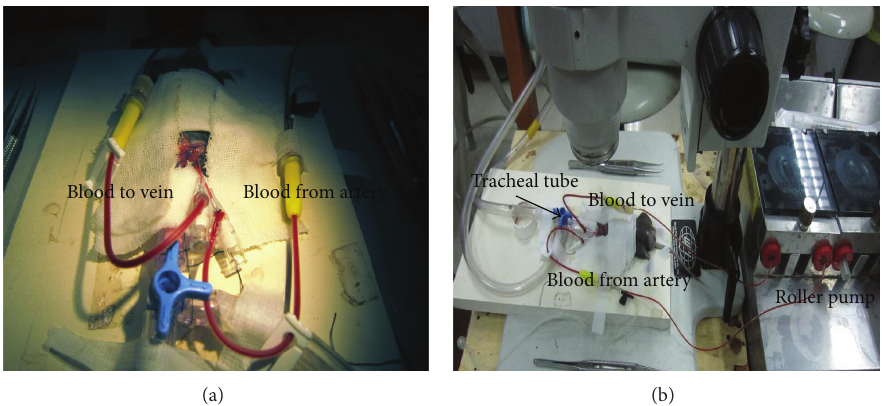
Figure 1: The mouse extracorporeal circulation circuit. Mice were anesthetized and mechanically ventilated. Both the right carotid artery (a.) and external jugular vein (v.) were cannulated and connected to a simplified ECC circuit comprising a sterile tube with a 1/32-inch inner diameter and a roller pump. Blood travelled from the right carotid (a. catheter) to the right external jugular (v. catheter).